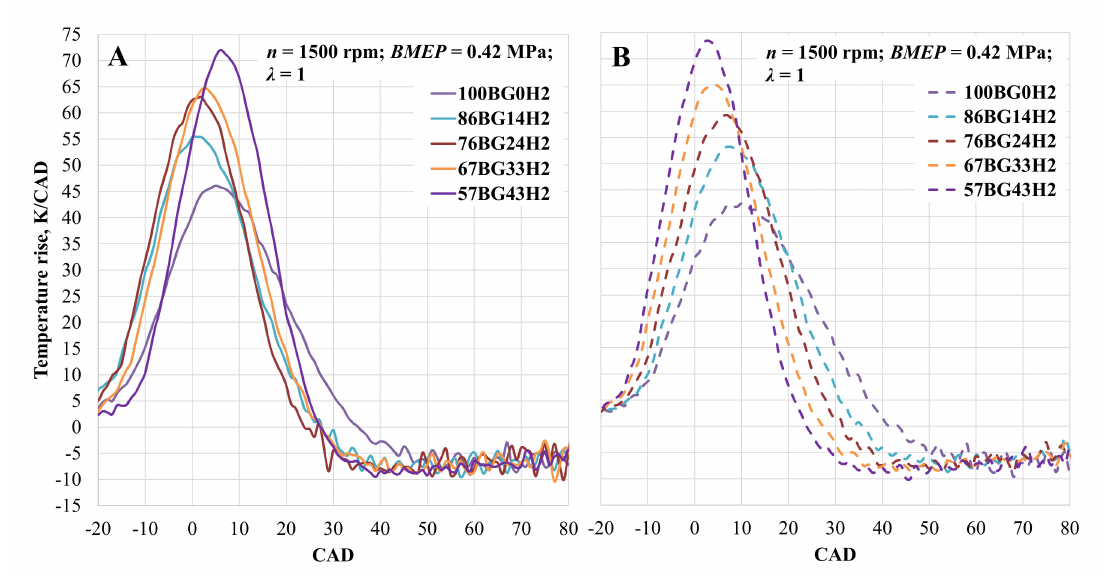
Figure 8. Temperature rise in the cylinder depending on hydrogen concentration. ( A )—with optimal ST for the mixture; ( B )—with optimal CNG